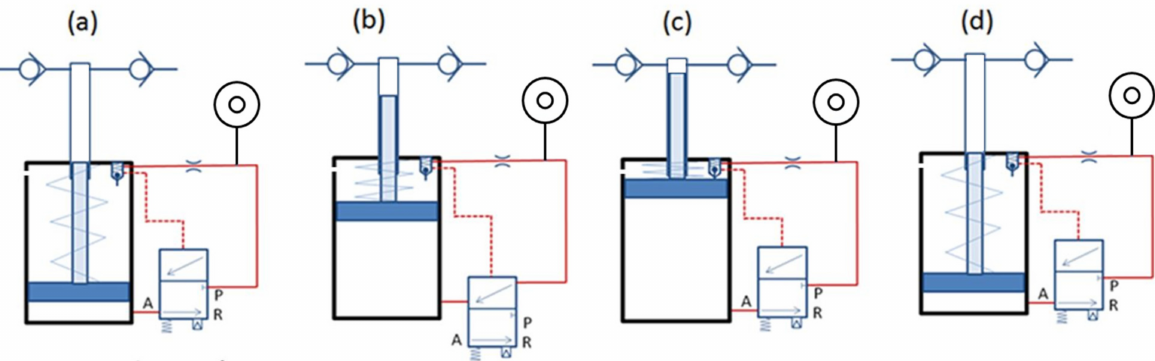
Figure 3. Working of the proposed needle-free jet injection system: ( a ) activation, ( b ) pressurization, ( c ) suction, ( d )